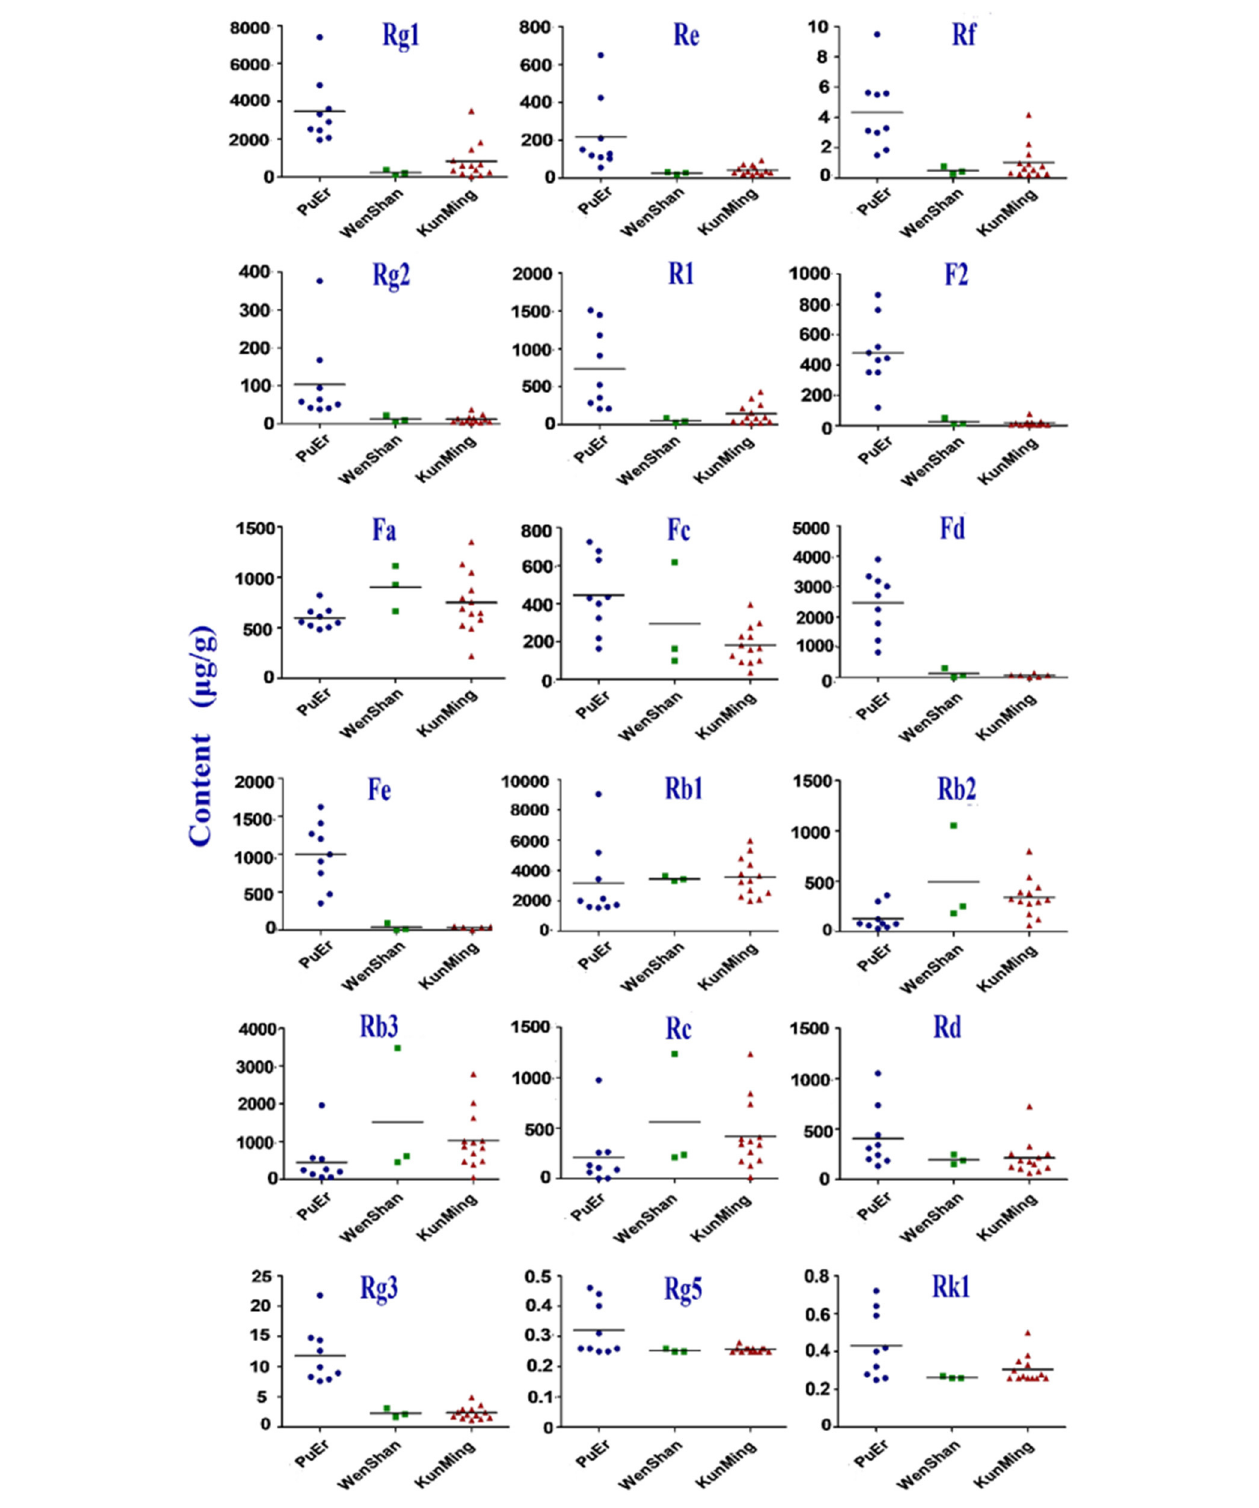
FIGURE 2 | Contents of 18 saponins in stem of P. notoginseng from different origins.